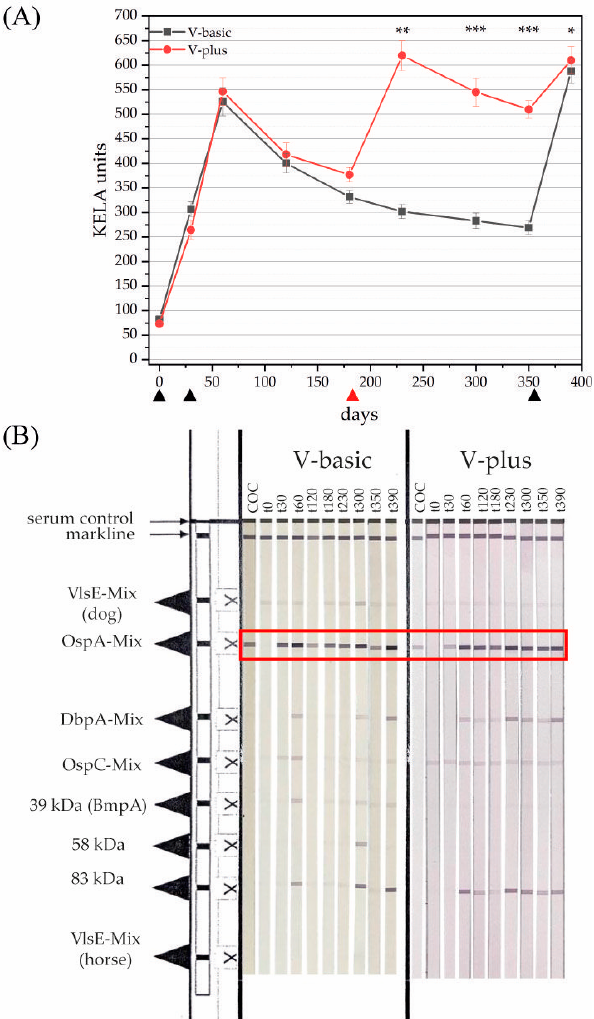
Figure 1. ( A ) Borrelia burgdorferi sensu lato-specific antibody levels in dog sera detected by KELA throughout the complete observation period. V-basic (vaccinated on days t0, t30, and t350) displayed as black squares; V-plus (vaccinated on days t0, t30, t180, and t350) shown as red circles. The whiskers depict the standard deviation at a specific time point. Black triangles show vaccination time points in both groups, while the red triangle indicates the additional booster vaccination in V-plus. ( B ) LIA strips for representative dogs from V-basic (left side) and from V-plus (right side) displaying semi-quantitative antibody reactions throughout the observational period. The first LIA strip shows the COC, which is used to determine the degree of color reaction intensity of each antigen line. Following right are the strips incubated with canine sera representative for two vacination groups in chronological order from t0 to t390. The vaccination-specific antigen signal on the LIA strips is the OspA-Mix (red box). * p ≤ 0.05; ** p ≤ 0.001; *** p ≤ 0.0001.